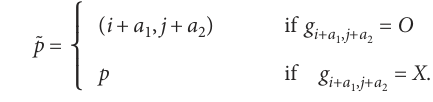
sub-problems: (1) to find a “good” cell decomposition of the environment, and (2) to find the optimal order of visits of the